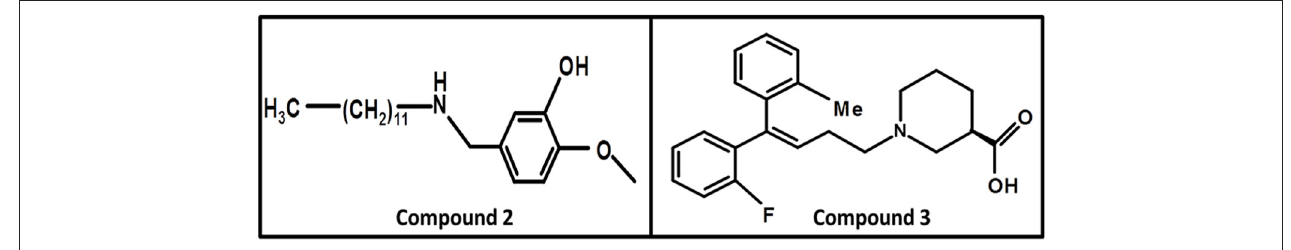
ring resulted in the potentially moderate azetidine derivatives of GAT1 e.g., 3-Hydroxy-3-(4-methoxyphenyl) (compound 8 , IC 50 = 26.6 µ M) and GAT3 (compound 9 , IC = 31 µ M) as shown in 50 Figure 11 . Additionally, the insertion of 4,4-diphenylbutenyl or 4,4-bis(3-methyl-2-thienyl)butenyl moiety N-alkylated lipophilic side chains exhibited azetidine-2-ylacetic acid derivatives that ensured the highest activity against GAT1 (compound 10 , IC 50 = 2.83 µ M and compound 11 , IC = 2.01 µ M). Whereas, 50 the most active compound against GAT3 was the β -alanine analog 1-{2-[tris(4-methoxyphenyl)methoxy]ethyl}azetidine-3- carboxylic acid (compound 12 ) with an IC 50 = 15.3 µ M ( Figure 11 ) (Faust et al.,